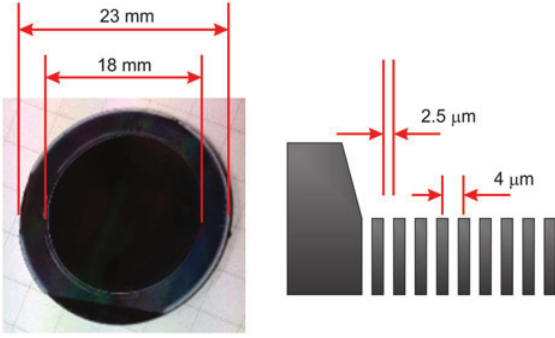
Figure 1 Si micromonolith picture and scheme showing the char- acteristic